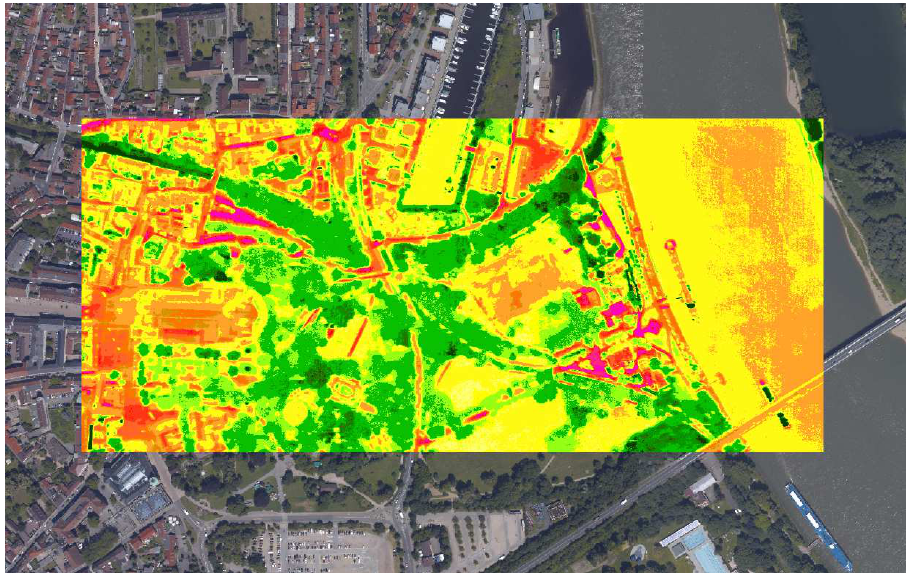
Figure 12: Example of a ThIR Orthomosaic overlaid on an Orthophoto of a test site in Speyer